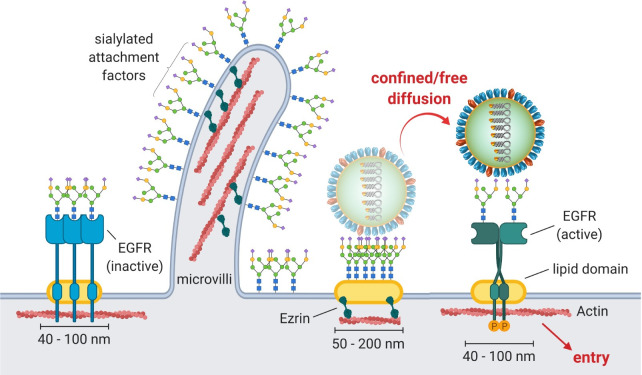
Model for IAV-mediated cell binding, receptor search and activation.Using quantitative STORM imaging, we could show that SA-conjugated IAV AF as well as one functional receptor, EGFR, form nanodomains in the plasma membrane of A549 cells. While dense AF nanodomains constitute an attractive multivalent binding platform, their diversity in local AF concentration suggests a variety of different residence times for which IAV would stay bound within these domains. Using single-virus tracking, we observed a mixed diffusive—confined motion, that could be simulated using our quantitative SA cluster information. These data suggest a receptor concentration-driven lateral search mechanism between SA enriched nanodomains. Eventually, since AF domains partly overlap with EGFR, IAV encounters a functional receptor that can be activated to signal cell entry. Our data further suggest that a stable preformed EGFR cluster population is activated during IAV stimulation, thereby possibly facilitating efficient signal transduction. EGFR clusters are stabilized by lipid rafts as well as cortical actin.